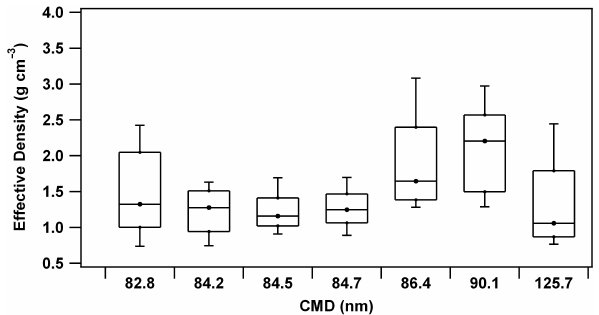
Figure 5. Measured effective density of ambient particles versus their size (count mean diameter, CMD) during mid-day (10:00– 13:00LT) of 7 consecutive days of sampling. In each box, the mid- line shows the median effective density value for the corresponding CMD value, the top and bottom show the upper and lower quar- tiles (the 75th and 25th percentiles), and the top and bottom of the whiskers are set to 90th and 10th percentile,